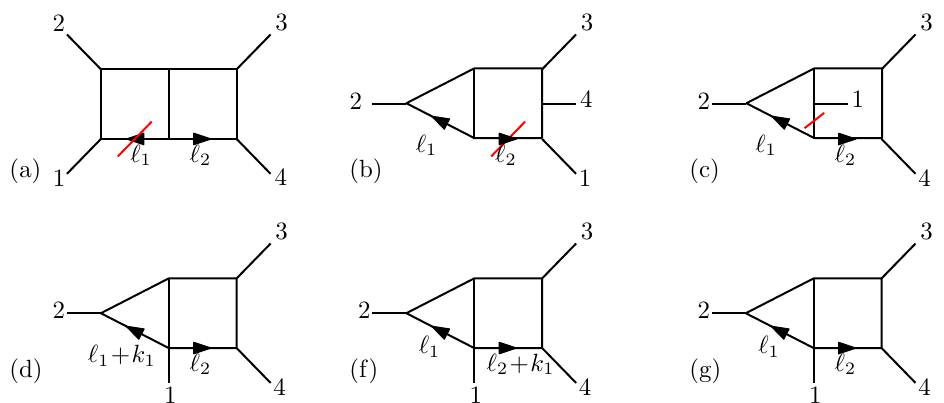
Figure 15 . Cancellation systematics at two-loops. Top: two-loop string amplitude with contours from eq. (5.2). Red lines correspond to propagators canceled by the phases of the monodromy relations. Bottom: contact terms generated by the J contours. While these graphs seem to constitute a Jacobi triplet, this would imply different definitions of the loop momentum than